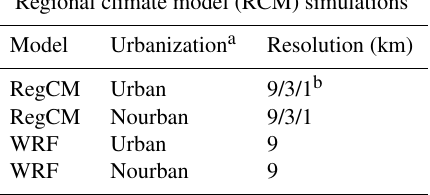
Table 1. The list of RCM simulations performed. Regional climate model (RCM)